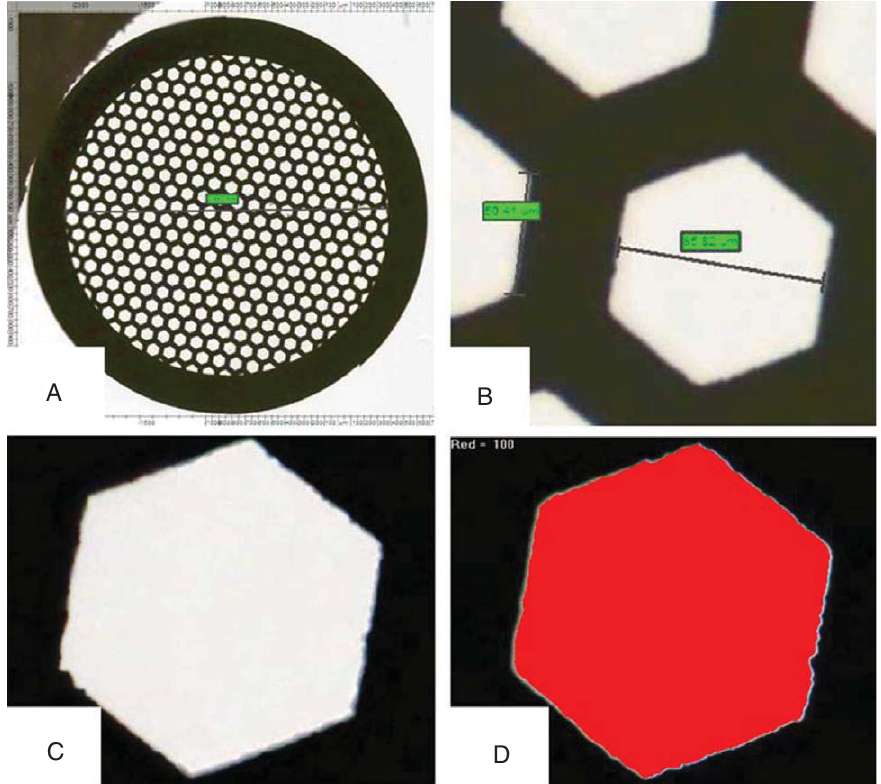
Fig. 2. A WSI of an electron microscopy copper grid. Panel A is low power view of the grid. Panel B is a medium power view of the “mesh” was measured with ImageScope TM . The dimensions were Length=50 microns and height 85 microns. Panel C is a high power view of a single mesh had the pre-calculated area of 6375um 2 . Panel D is the white space of C was “painted” with SIVQ. The area of paint was calculated to be 6375um 2 and was very